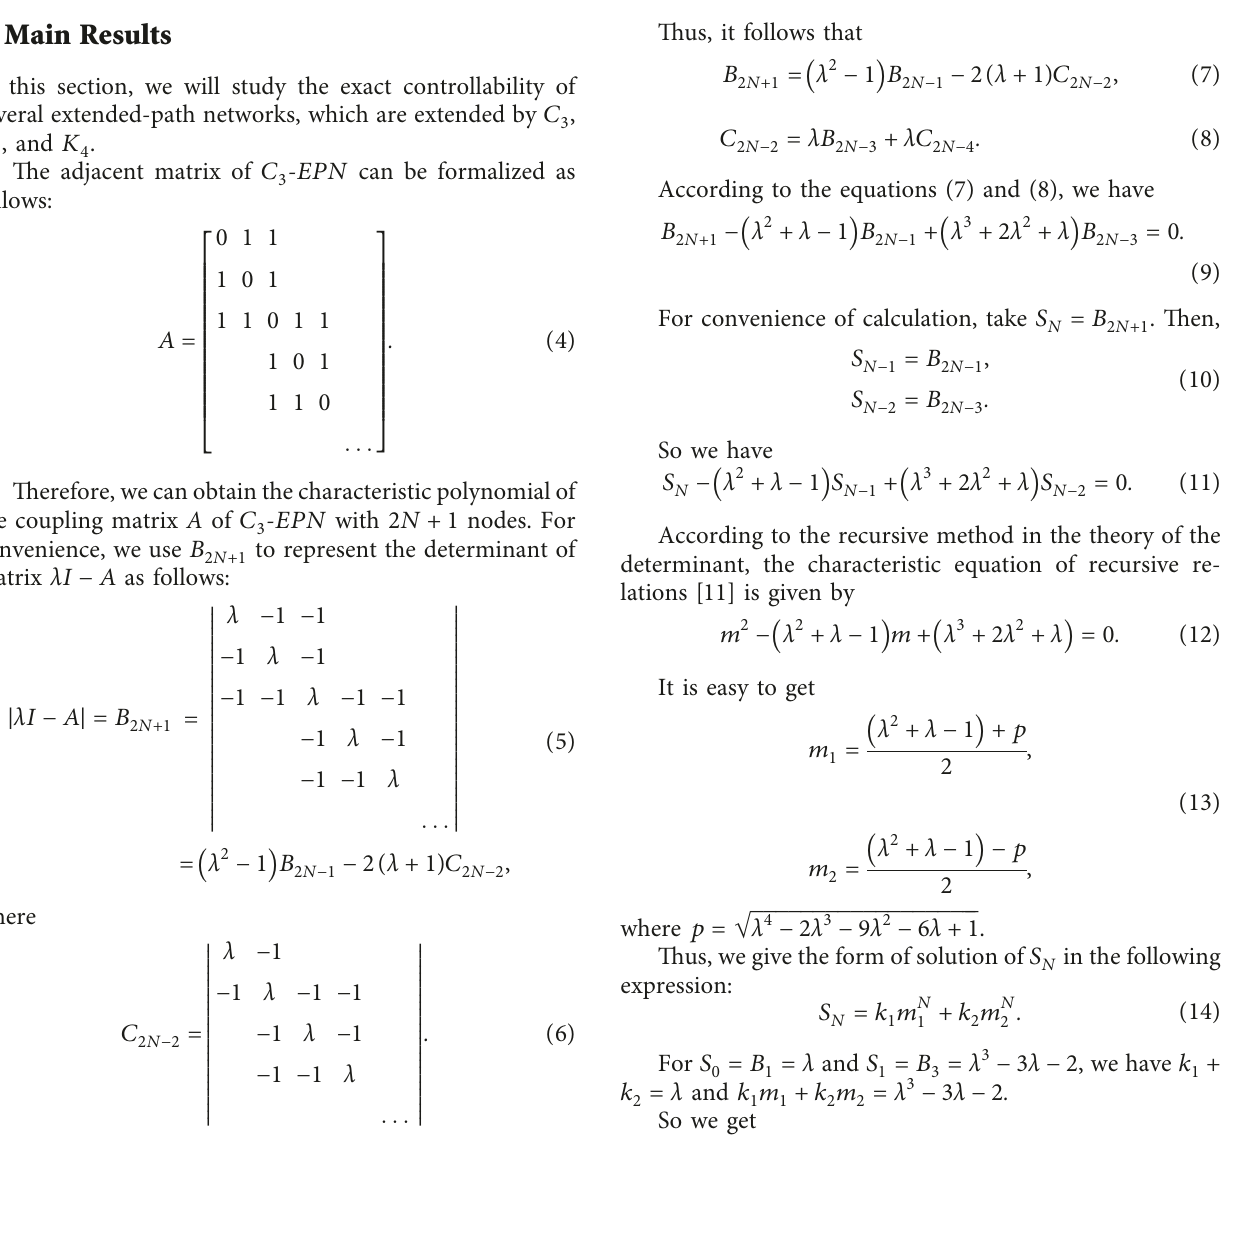
, C , and K . (a) C 3 - EPN . (b) C 4 - EPN 1. (c) C 4 - EPN 2. (d) K 4 - EPN 3 4 4